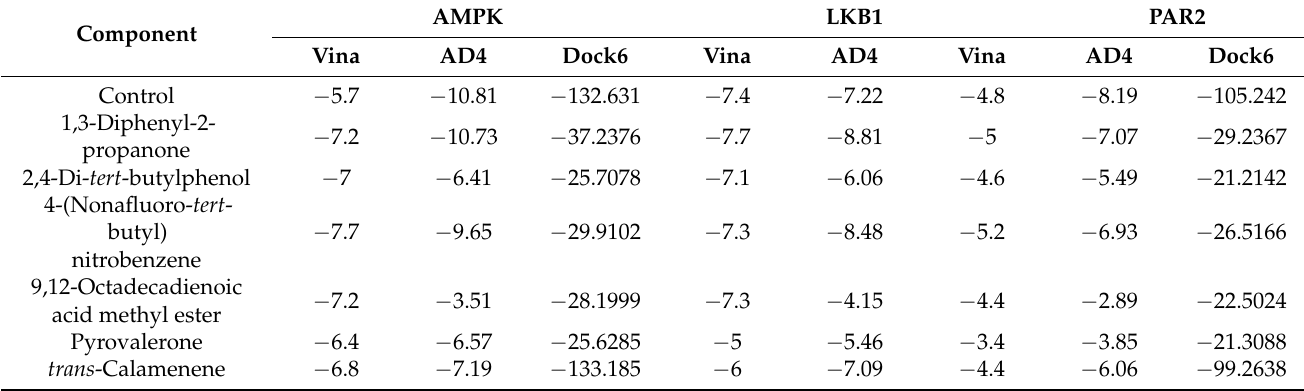
Table 3. In silico docking simulation of active volatile components of fermented soybean CGJ with AMPK, LKB1 and PAR2. Component